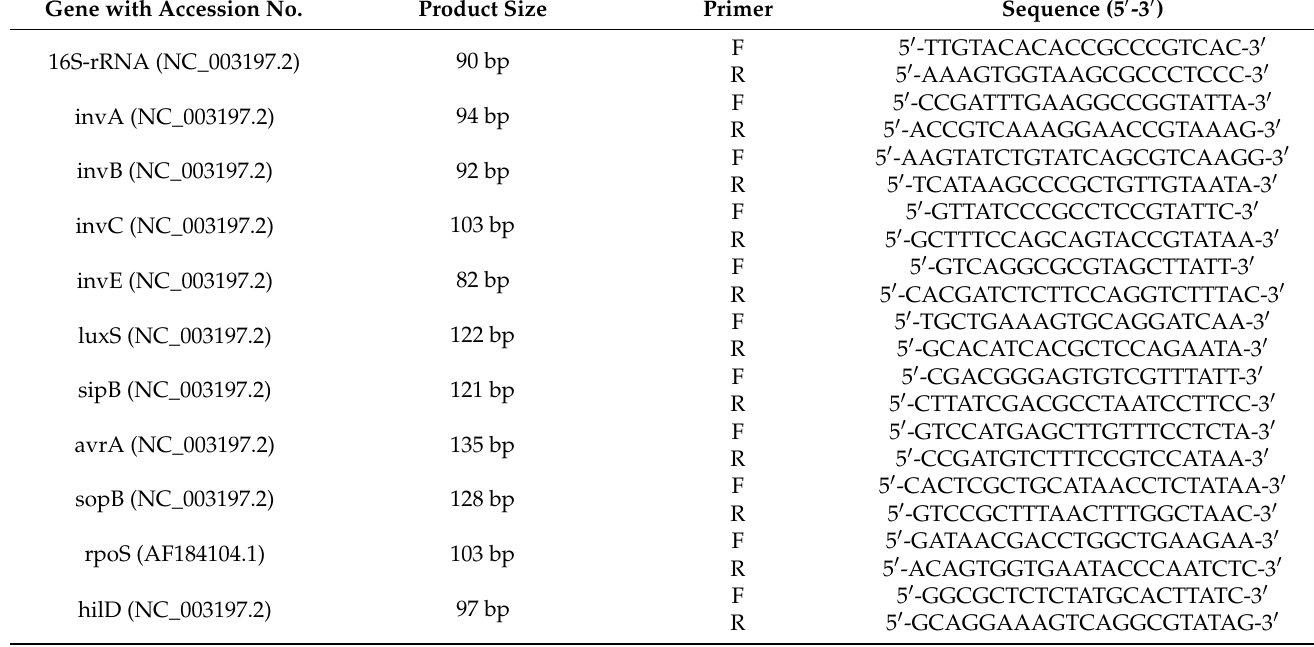
Table 1. Primers used for gene expression analysis using quantitative real-time PCR. Gene with Accession